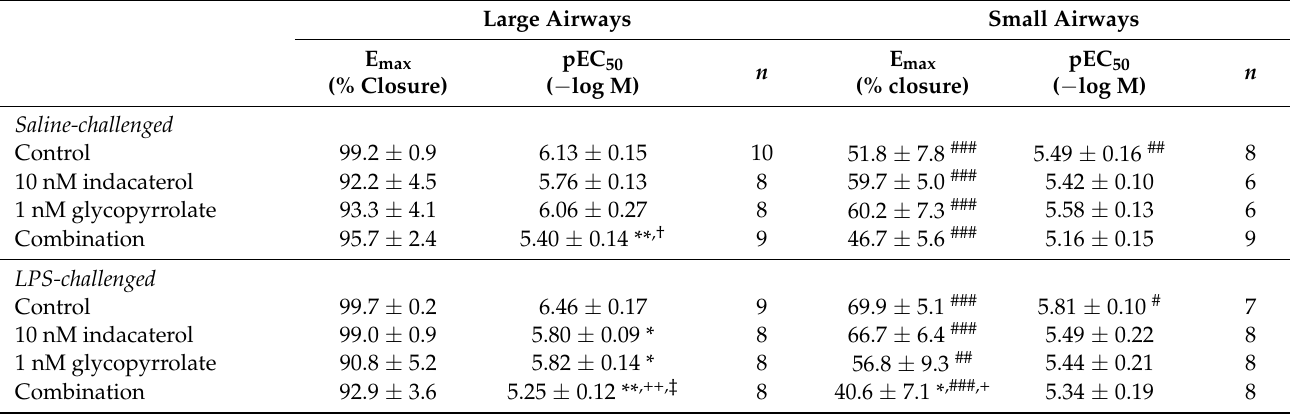
Table 4. Effects of indacaterol and glycopyrrolate on methacholine-induced airway constriction of large and small airways in guinea pig lung